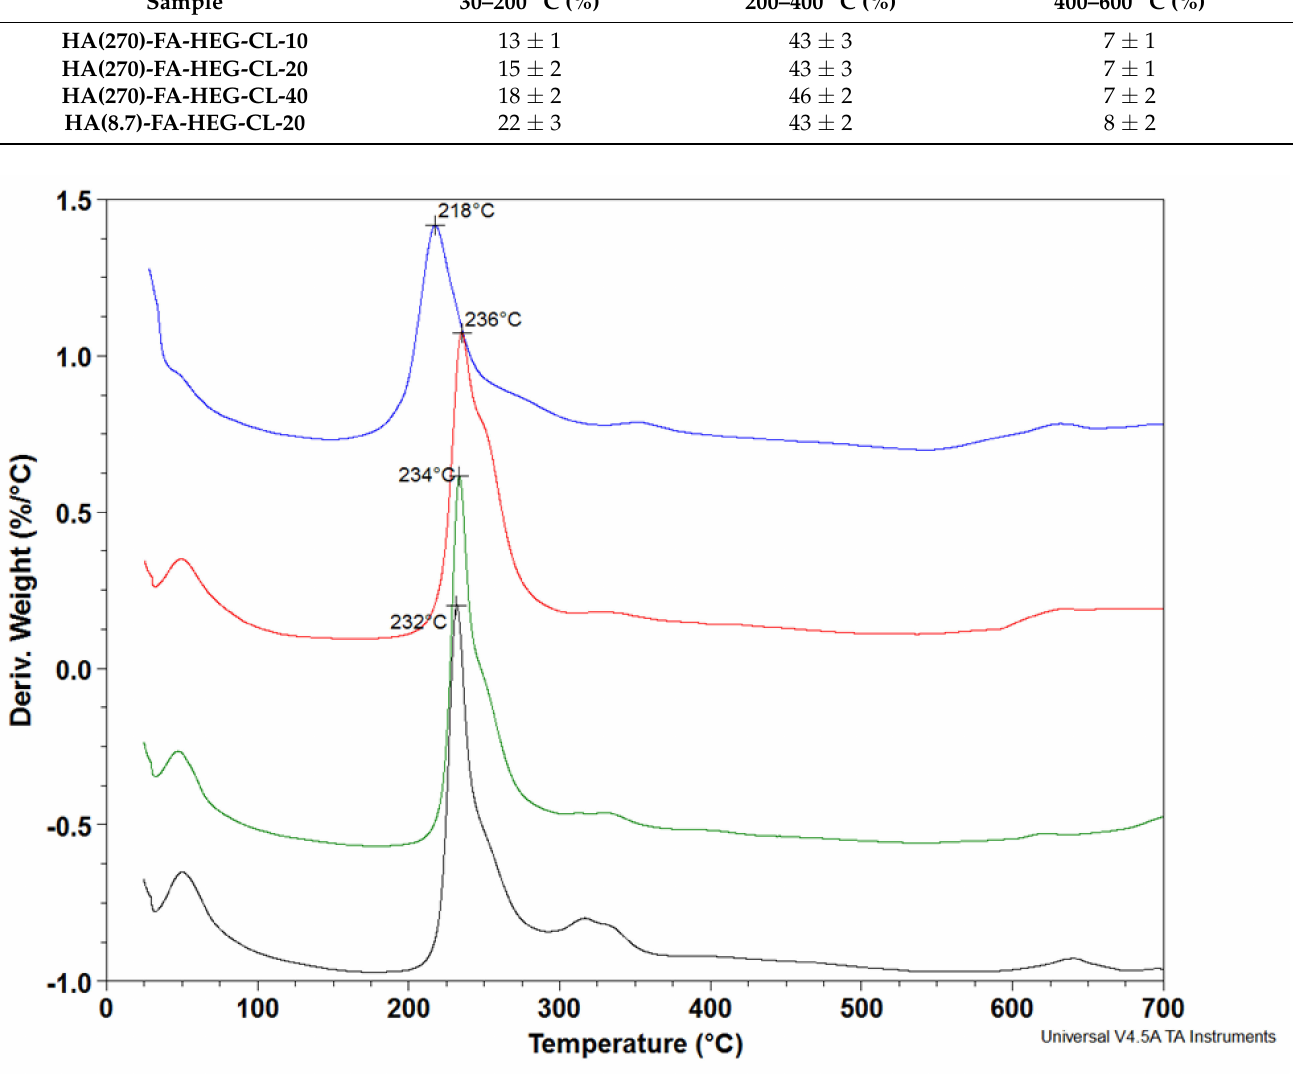
Figure 10. Thermographs obtained plotting the derivative of weight versus temperature (30–600 ◦ C) of the hydrogels obtained with HA(270)-FA-HEG-CL - 20 (green), HA(270)-FA-HEG-CL - 40 (black), HA(270)-FA-HEG-CL - 10 (red), and HA(8.7)-FA-HEG-CL - 20 (blue). HA-FA-HEG-CL derivatives obtained by crosslinking with CuAAC click chemistry reaction showed a significant decrease of the temperature (about 10 ◦ C) at which the main weight loss occurred in comparison with the native polymers (data not shown). 270 kDa series shows a similar thermal behavior with the main weight loss recorded at about 230 ◦ C despite the crosslinking density. A contrary sample HA(8.7)-FA-HEG-CL - 20 degrades at significantly lower temperatures (i.e., 218 ◦ C), according to its lower